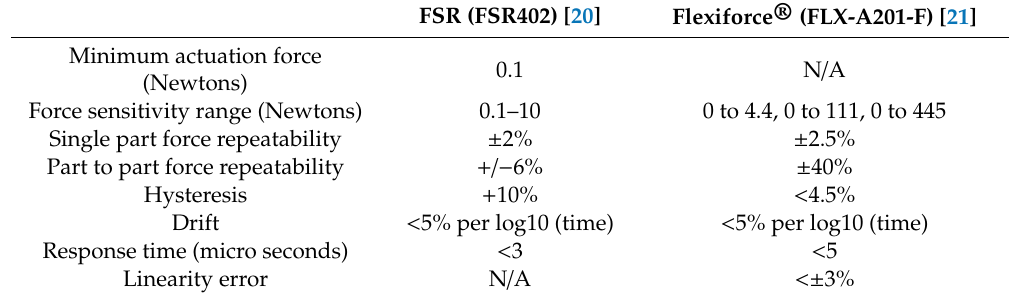
Table 1. Comparison chart between FSR and Flexiforce ® sensor.